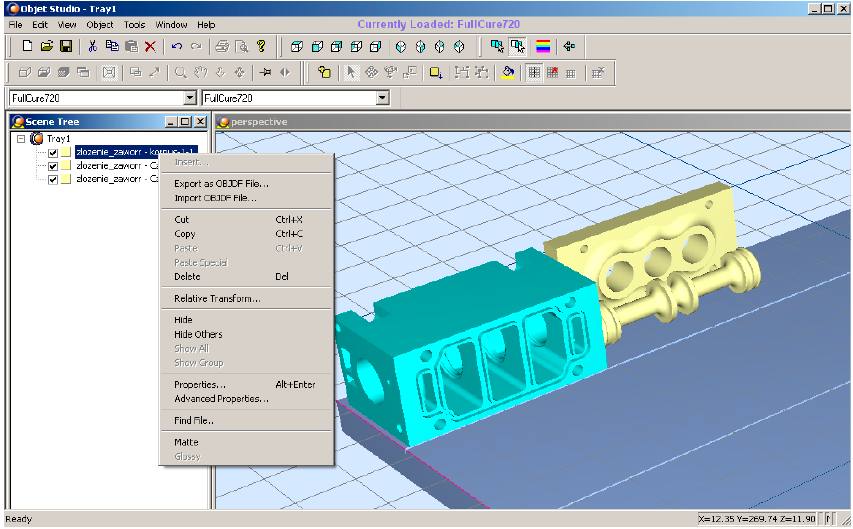
Figure 10. Objet Studio dialog box.